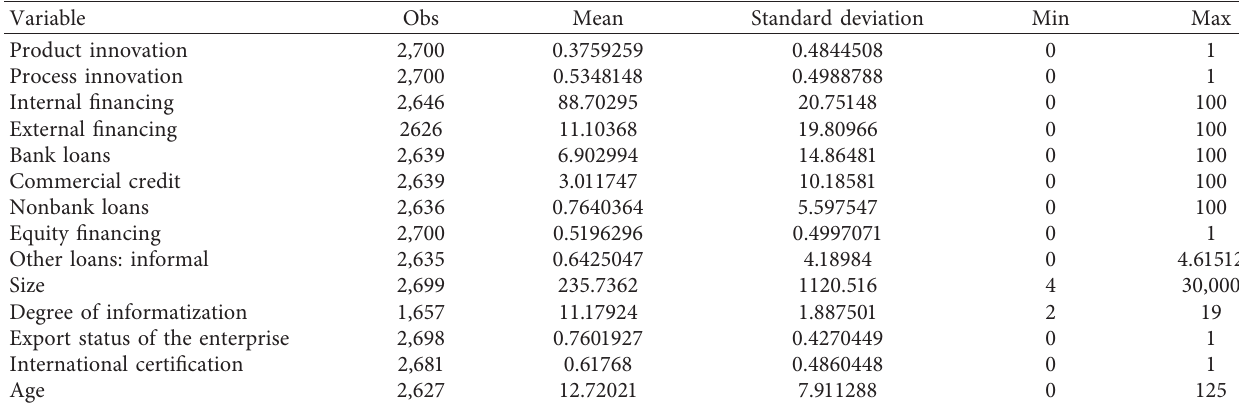
Table 5: Descriptive statistics of variables.